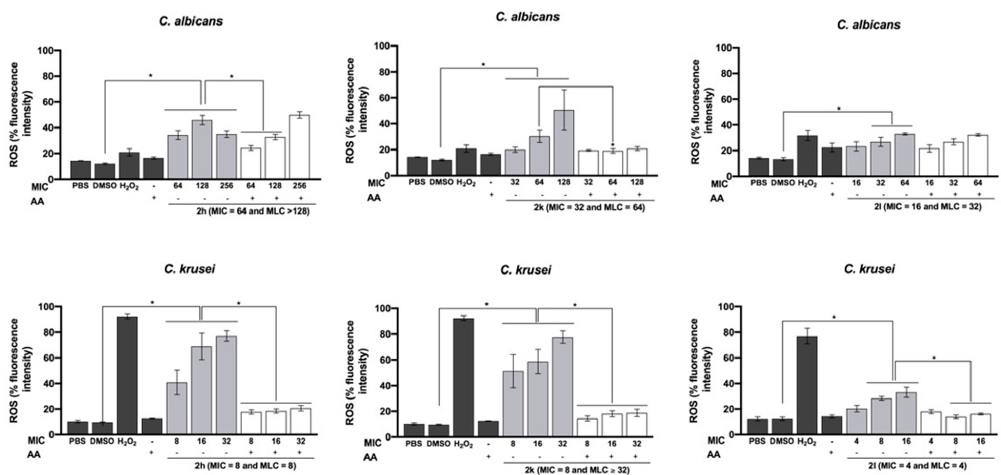
Figure 3. Effect of 5-aminoimidazole-4-carbohydrazonamide derivatives on reactive oxygen species (ROS) production in Candida albicans ATCC 10231 and Candida krusei ATCC 6258, after 6 h treatment. MIC, minimal inhibitory concentration. Ascorbic acid (AA; 5 mM) was used as antioxidant and H 2 O 2 (1 mM) as positive control for ROS detection. +, with AA and -, without AA. Data are mean ± SEM, n = 2–3 independent experiments; values significantly different from DMSO (0.5%): * p < 0.05, (two-way ANOVA followed by Dunnett’s test).